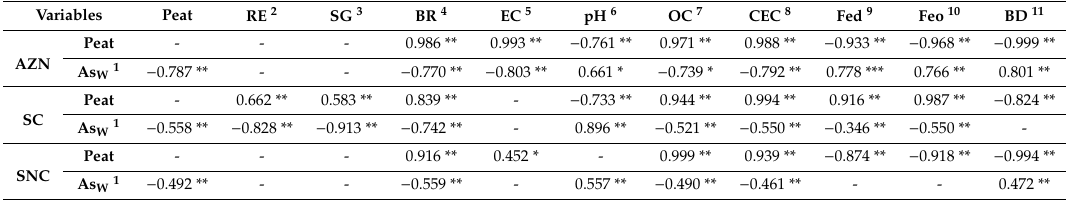
Table 3. Spearman correlations between di ff erent soil samples, remediation treatment with peat, and the solubility of As in